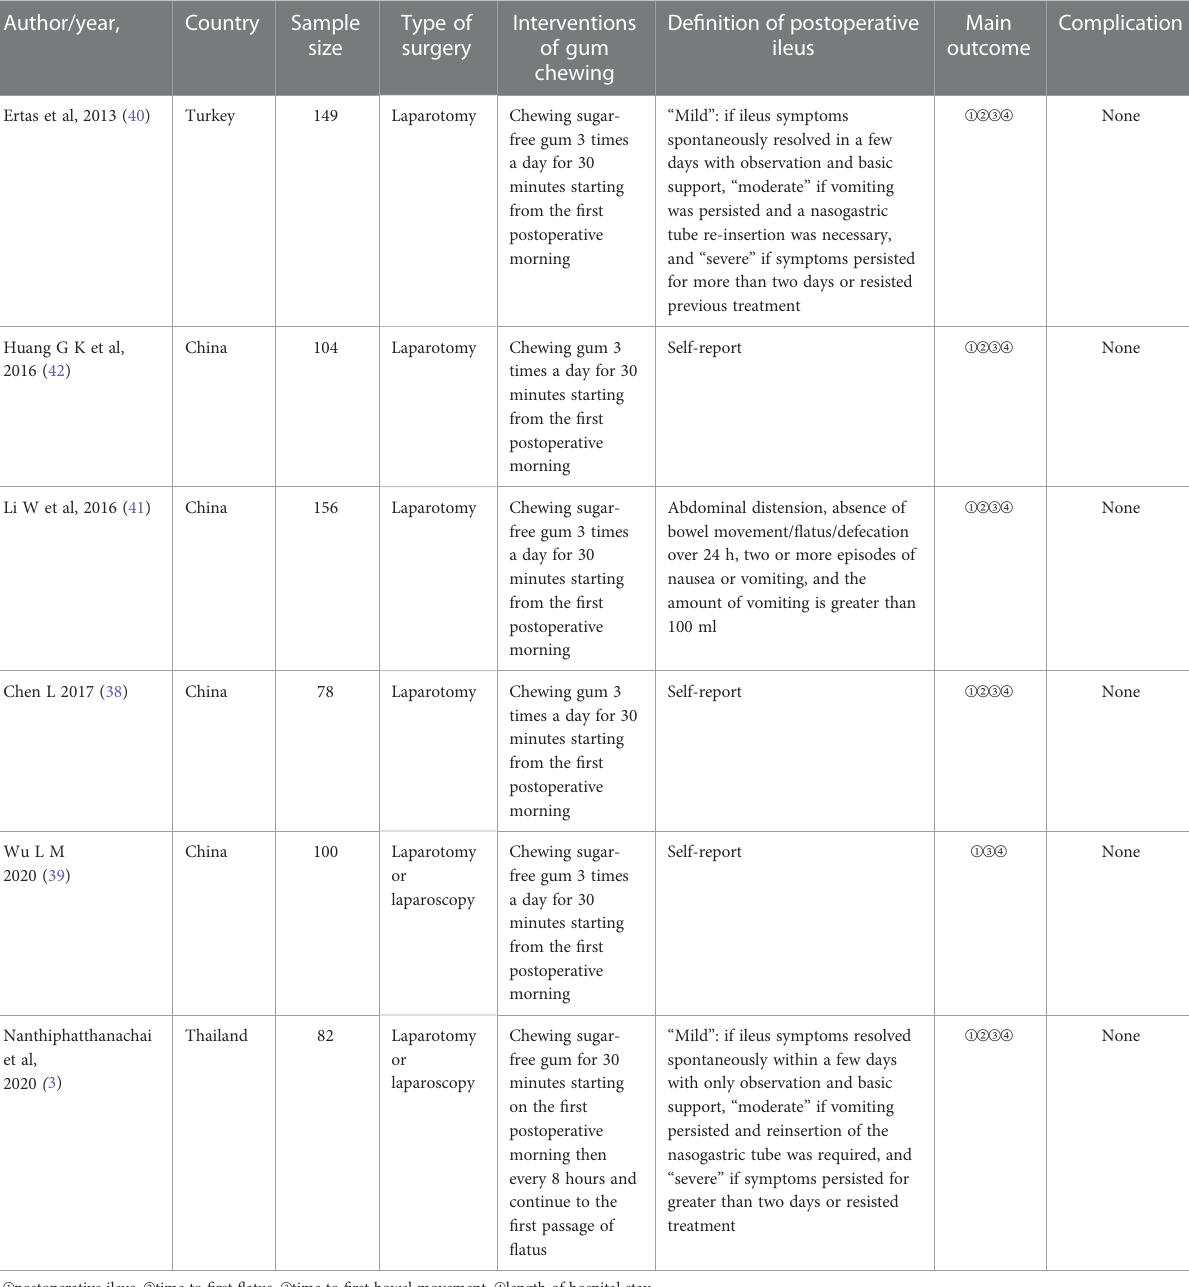
TABLE 2 Characteristics of gum chewing intervention in the six included randomized controlled